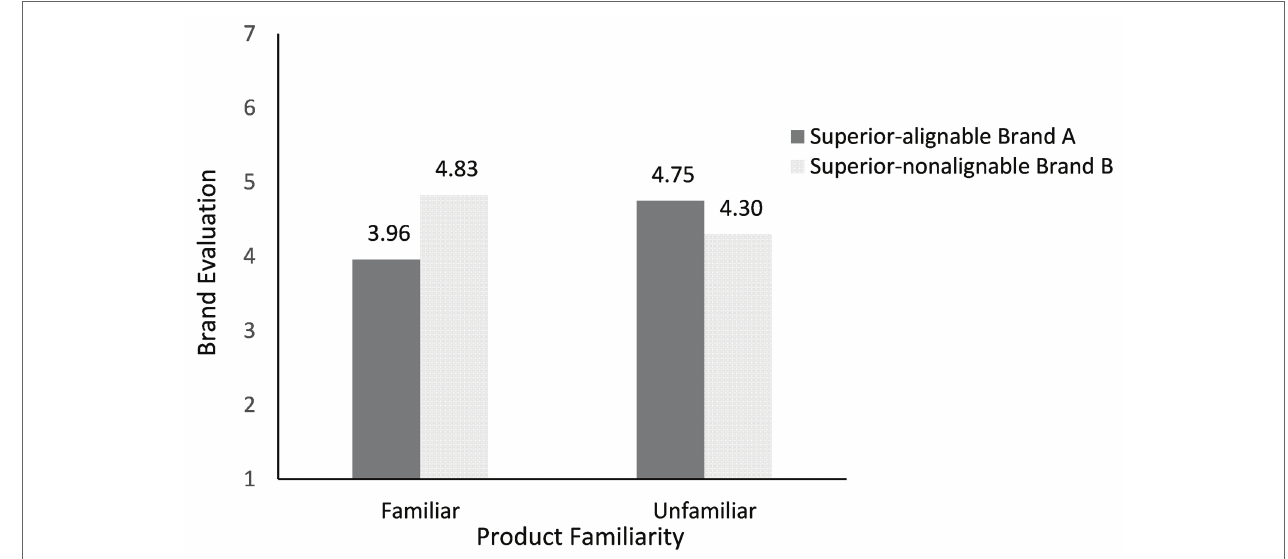
FIGURE 3 | Effects of product familiarity and attribute alignability on brand